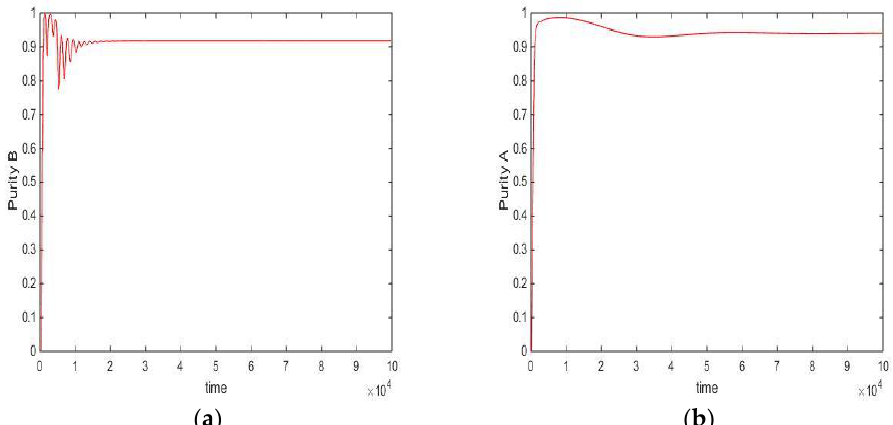
Figure 7. Control results of the first experiment (switch time = 180 s; desired A = 94%, desired B = 92%). ( a ) Extraction outlet (material B); ( b ) raffinate outlet (material A).